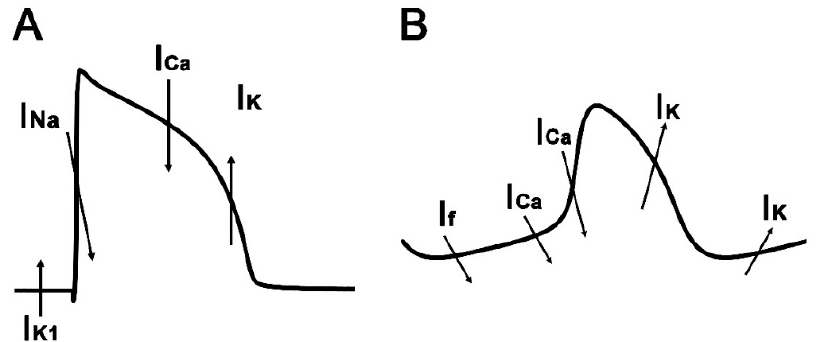
Figure 1. The action potential waveform of the working myocardium ( A ) and the sinus node ( B ). The ion channel currents responsible for each segment are indicated by arrows. The upward and downward arrows indicate outward and inward currents, respectively.